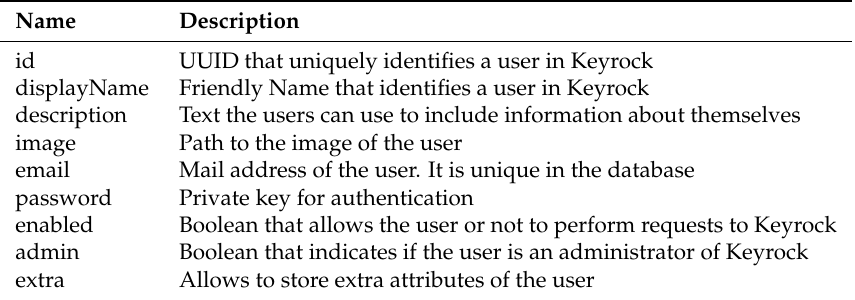
Table 5. Relevant attributes in Keyrock’s user